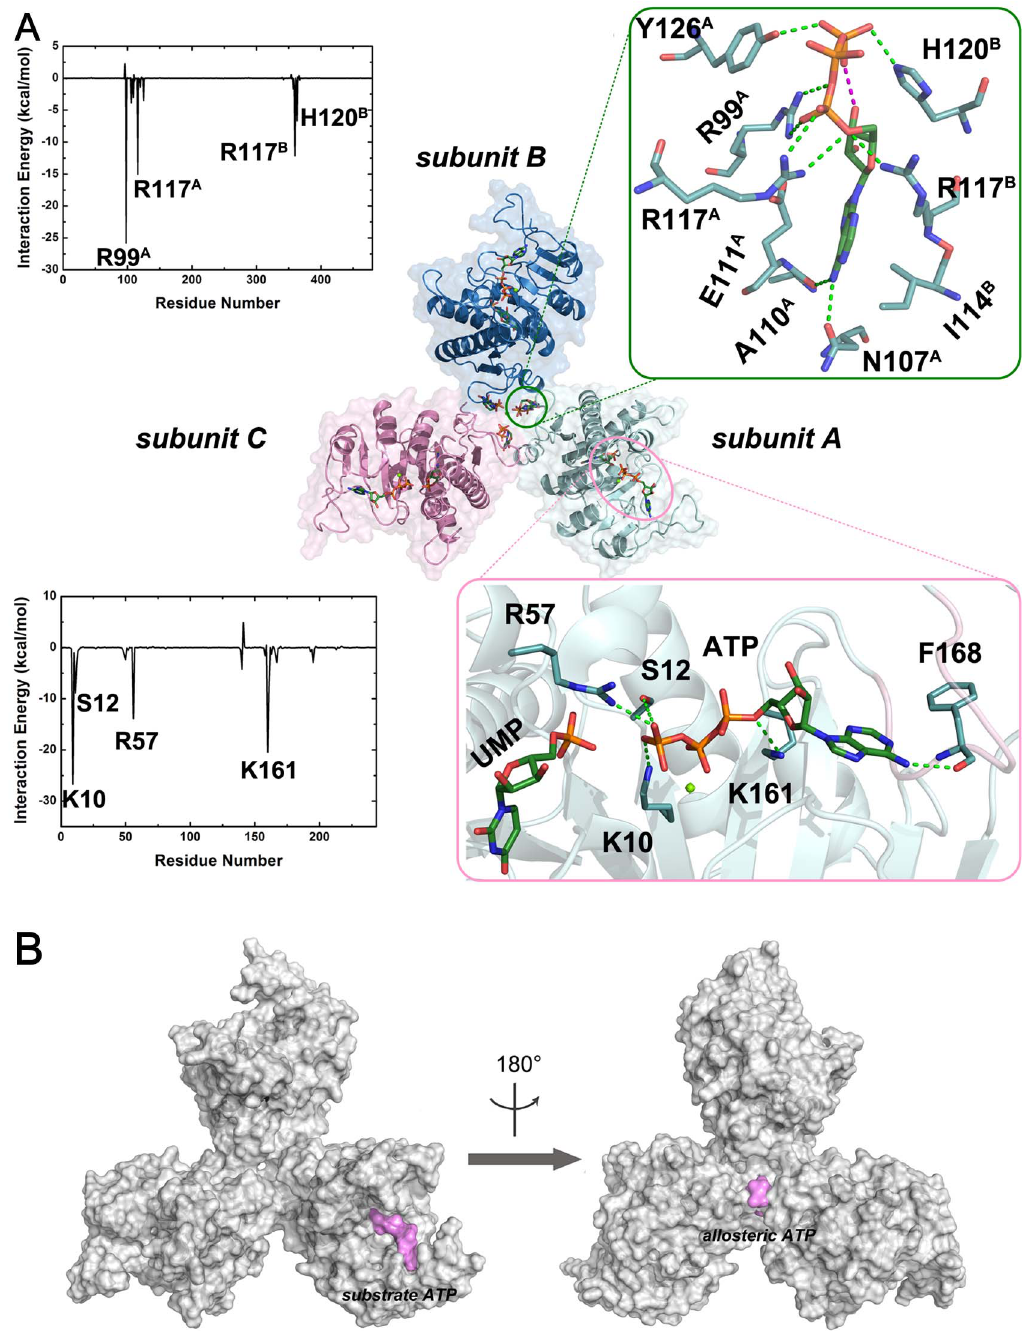
Figure 4. The interactions between UMP kinase and allosteric and substrate ATP molecules. (A) The energy contributions to the binding of allosteric and substrate ATP molecules to the UMP kinase, and the binding modes between the allosteric and substrate ATP molecules and the UMP kinase. The green dashes represent hydrogen bonds. The hydrogen atoms are not displayed for clarity. (B) The volume and shape of the allosteric and substrate ATP-binding sites of the UMP